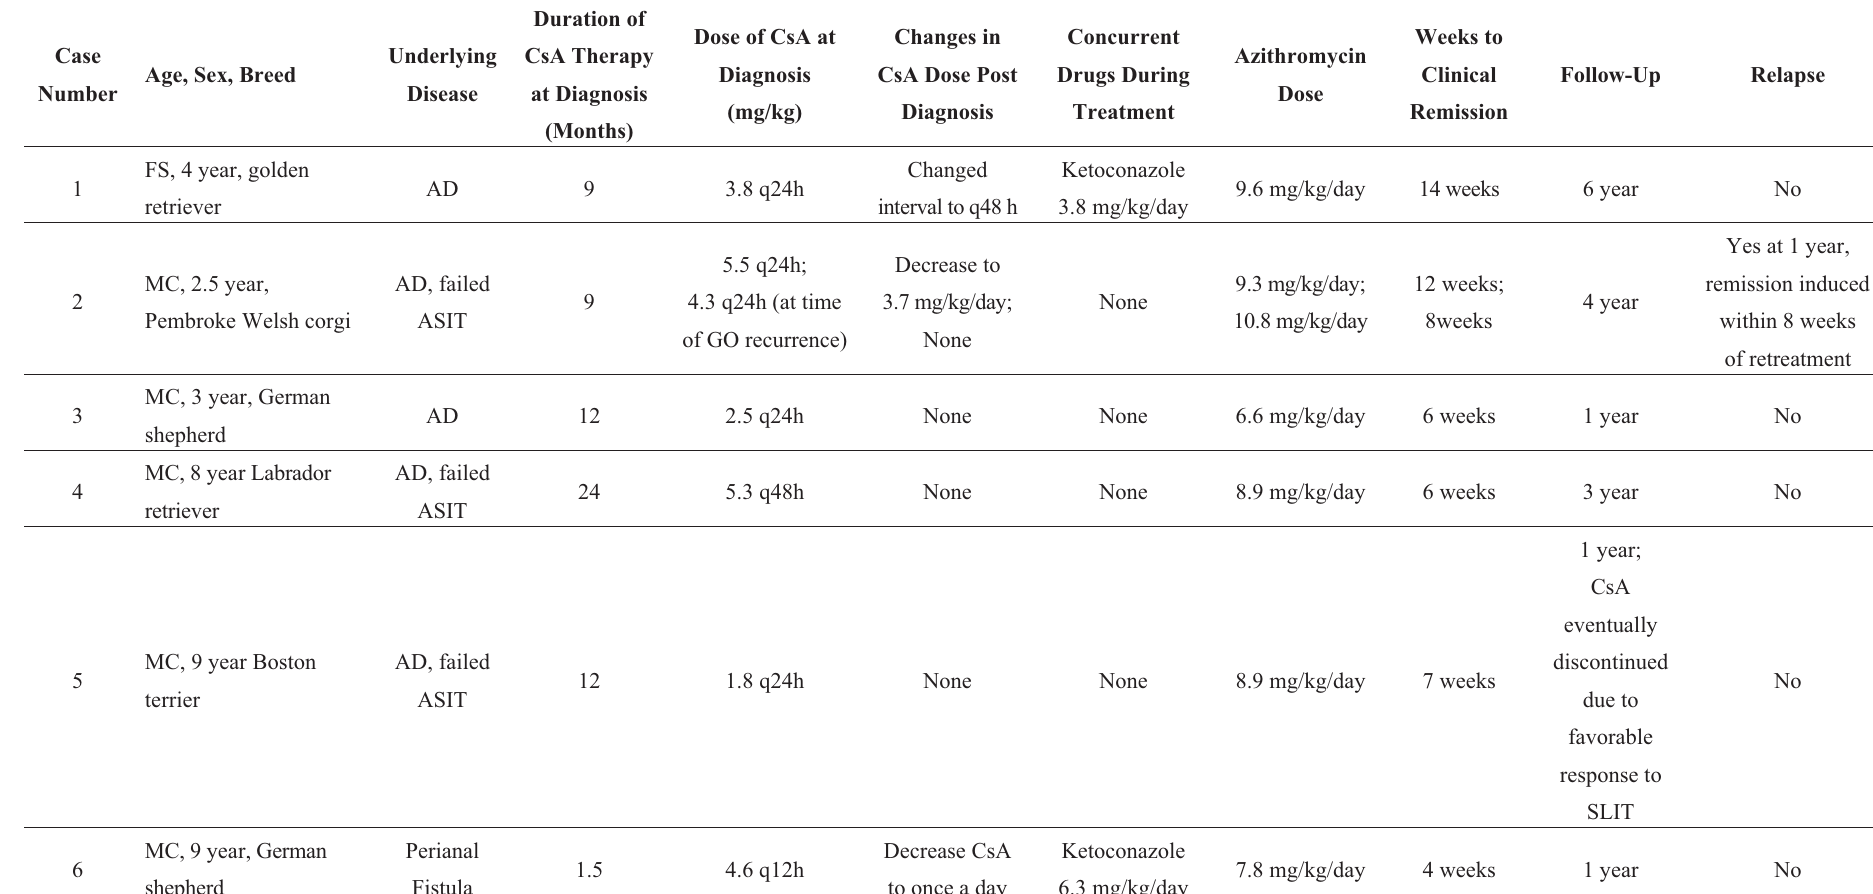
Table 1. Signalment and summary of case specific